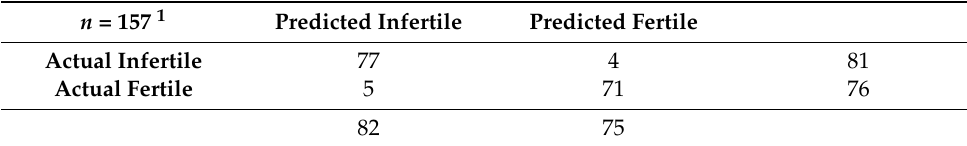
Table 3. Confusion matrix for